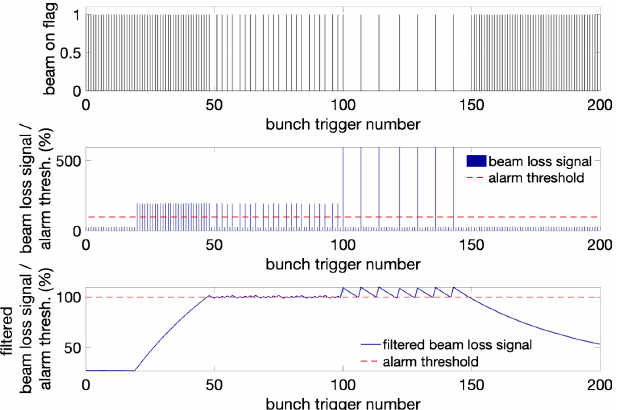
FIG. 5. Principle of the MPS